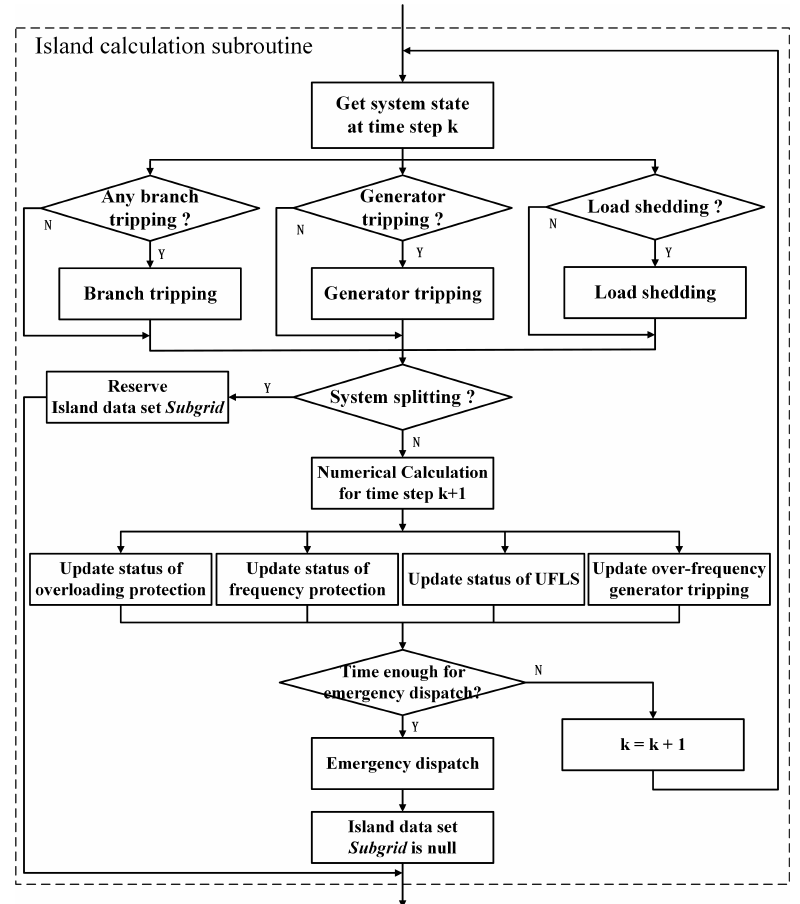
Figure 4. Flow chart of island calculation